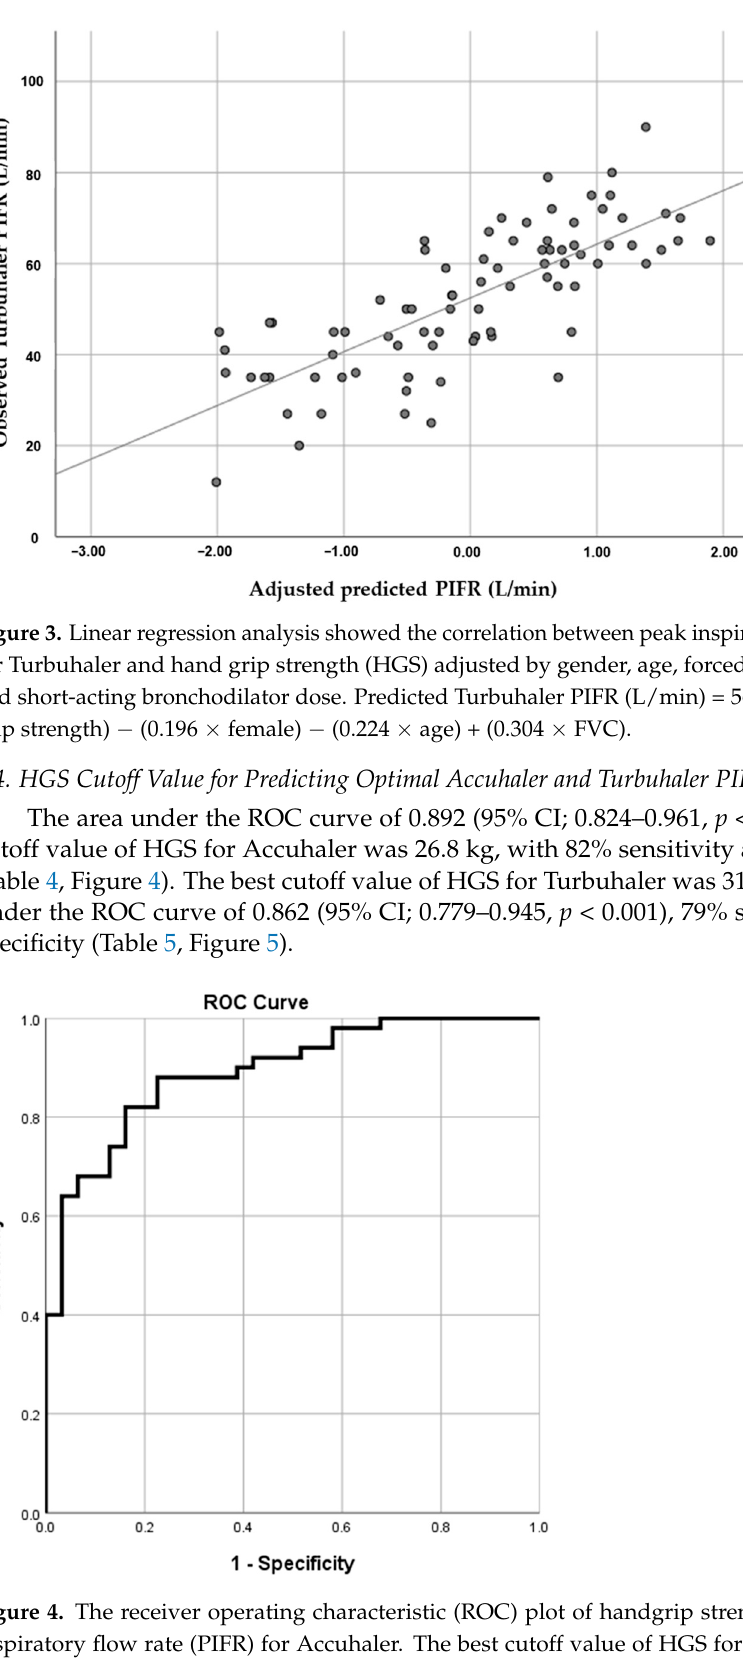
Figure 4. The receiver operating characteristic (ROC) plot of handgrip strength (HGS) and peak inspiratory flow rate (PIFR) for Accuhaler. The best cutoff value of HGS for Accuhaler is 26.8 kg, with the area under the ROC curve of 0.892 (95% CI; 0.824–0.961, p <0.001), 82% sensitivity, and 84% specificity.